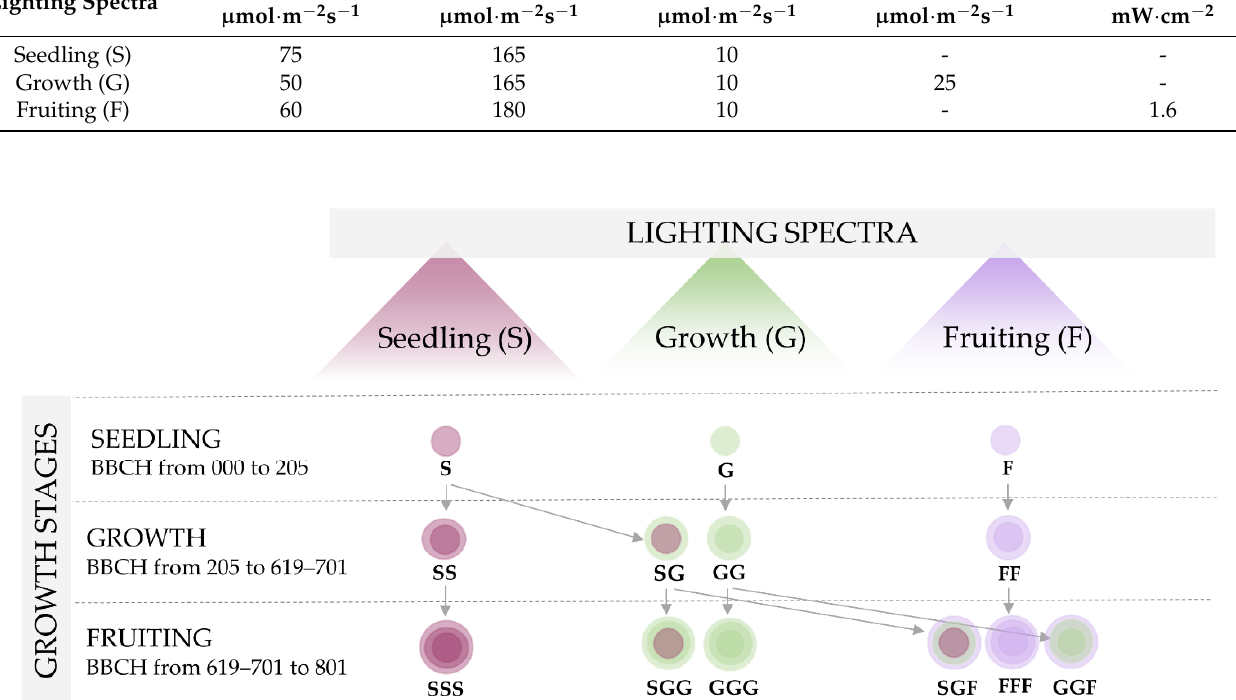
Table 1. Experimental lighting spectra. Photon flux densities (PFD) of individual spectrum components. Lighting Spectra